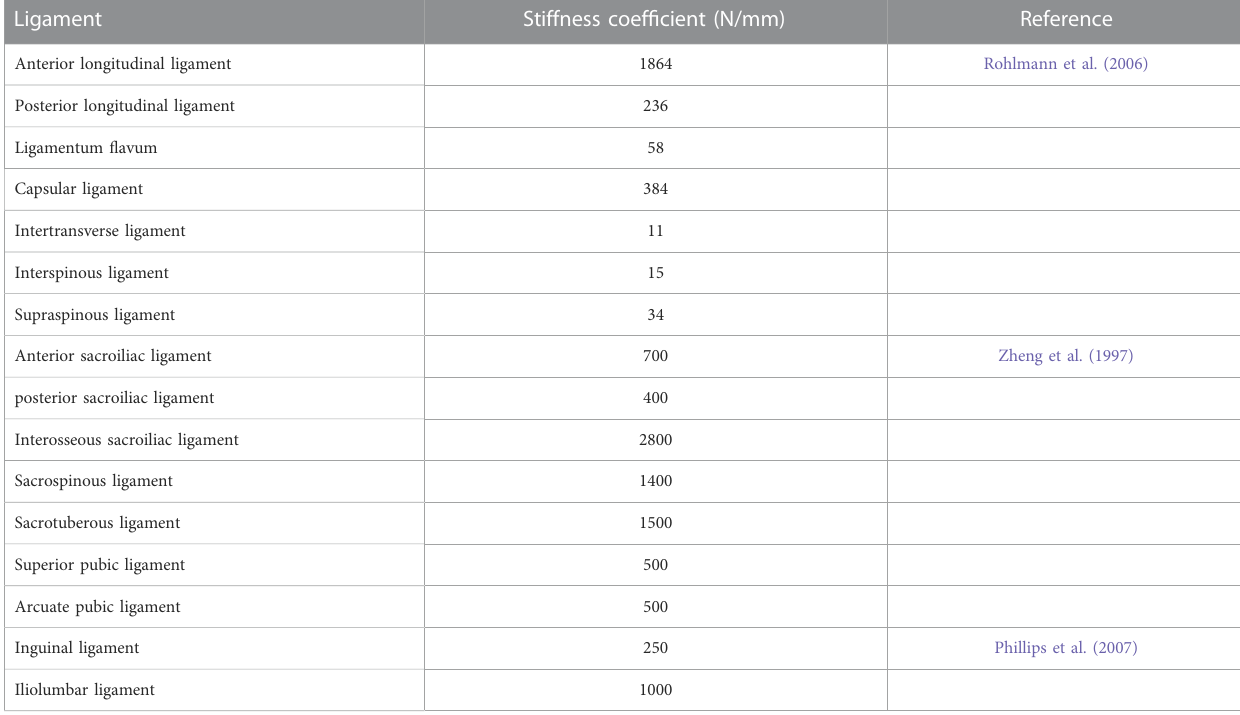
TABLE 2 Material properties of the lumbar and pelvic ligaments.